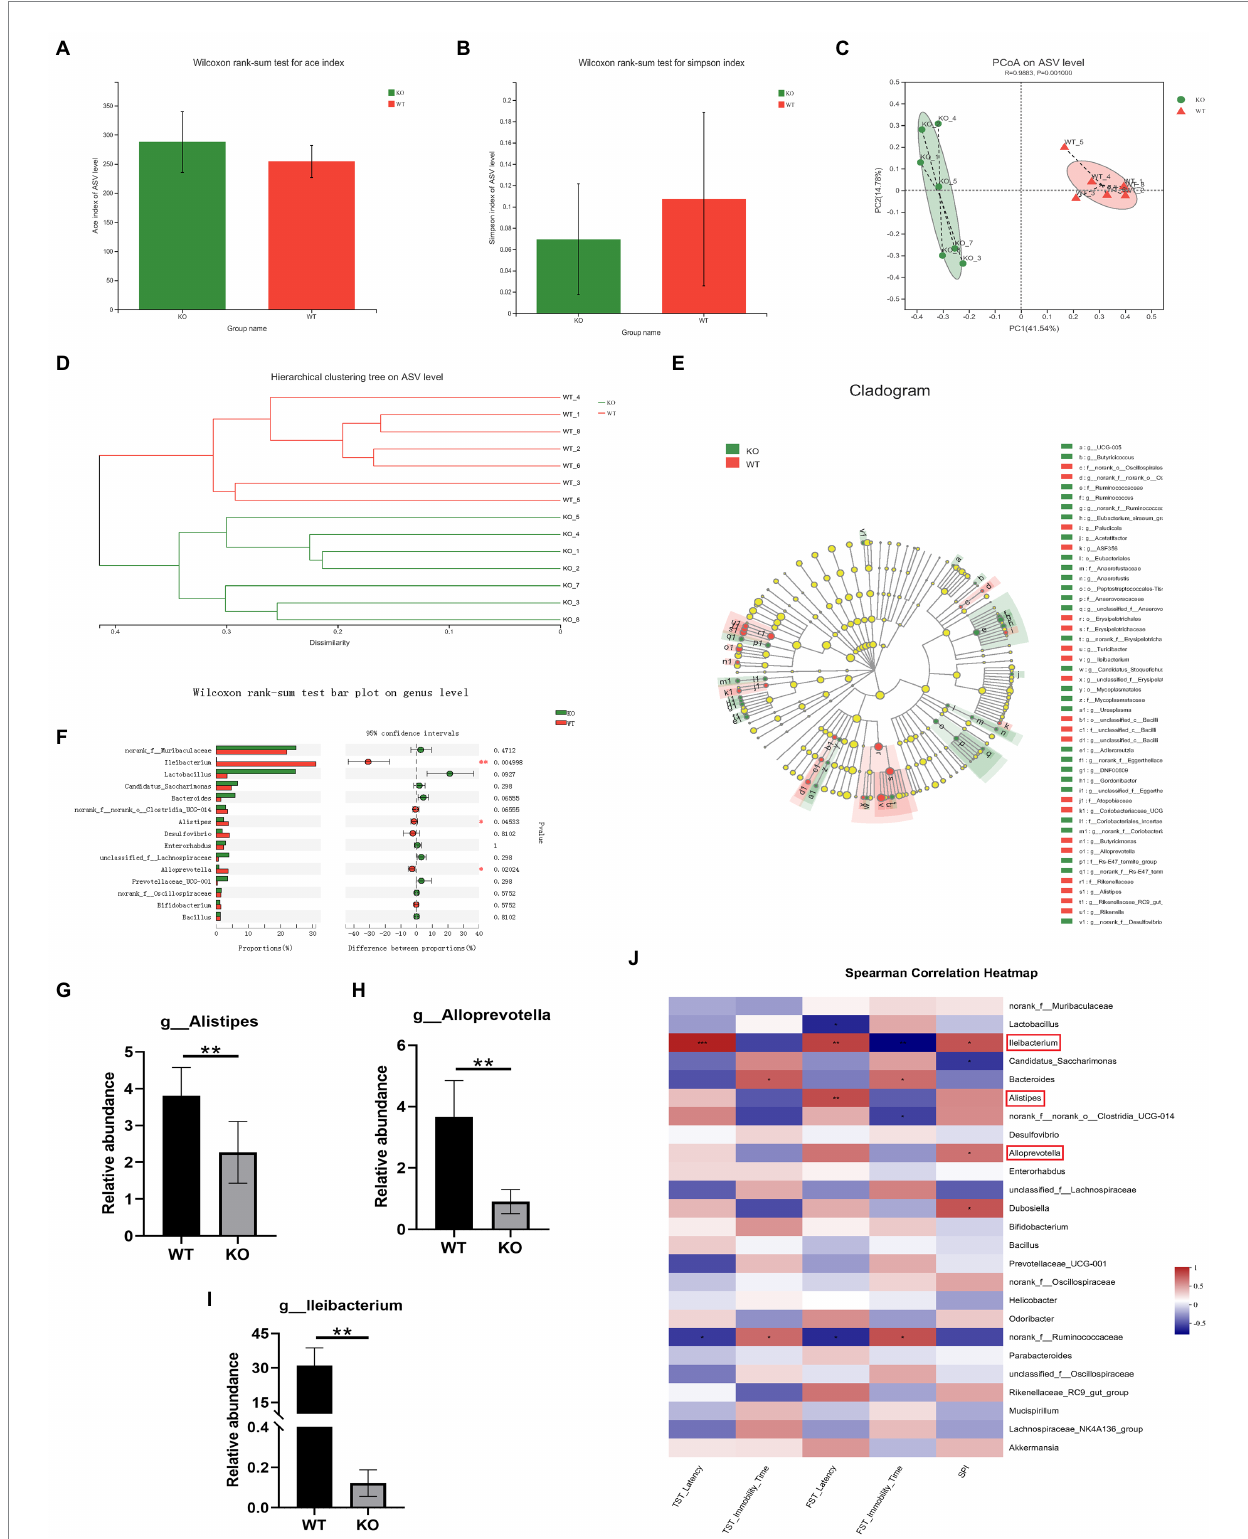
FIGURE 3 Sig-1R knockout induced dysbiosis of the gut microbiota. (A) ACE index and (B) Simpson index of the gut microbiota. (C) PCoA and (D) hierarchical clustering of 16S rRNA gene sequences. (E) The LEfSe analysis of the gut microbiota from the phylum level down to the genus level. (F) Composition of the gut microbiota at the genus level. (G–I) The relative abundance of Alistipes , Alloprevotella , and Lleibacterium. ** p <0.01. WT, n = 6; KO, n = 6. (J) The correlation between the gut microbiota and depressive-like behaviors in WT and KO mice was analyzed using Spearman’s correlation analysis. The red color represents a positive correlation; the blue color represents a negative correlation. Asterisk-marked columns indicated significant correlation. *0.01 < p ≤ 0.05, **0.001 < p ≤ 0.01, and *** p ≤